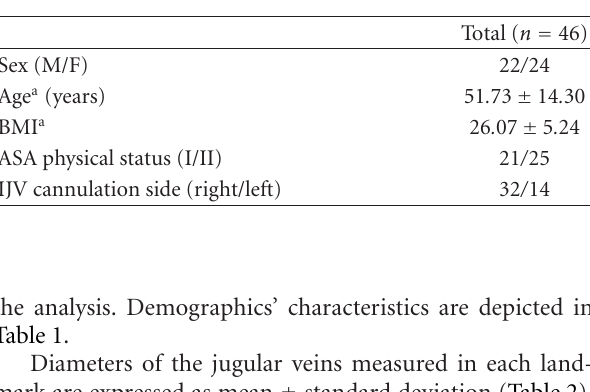
Table 1: Demographic characteristics. a Values are expressed as mean ±